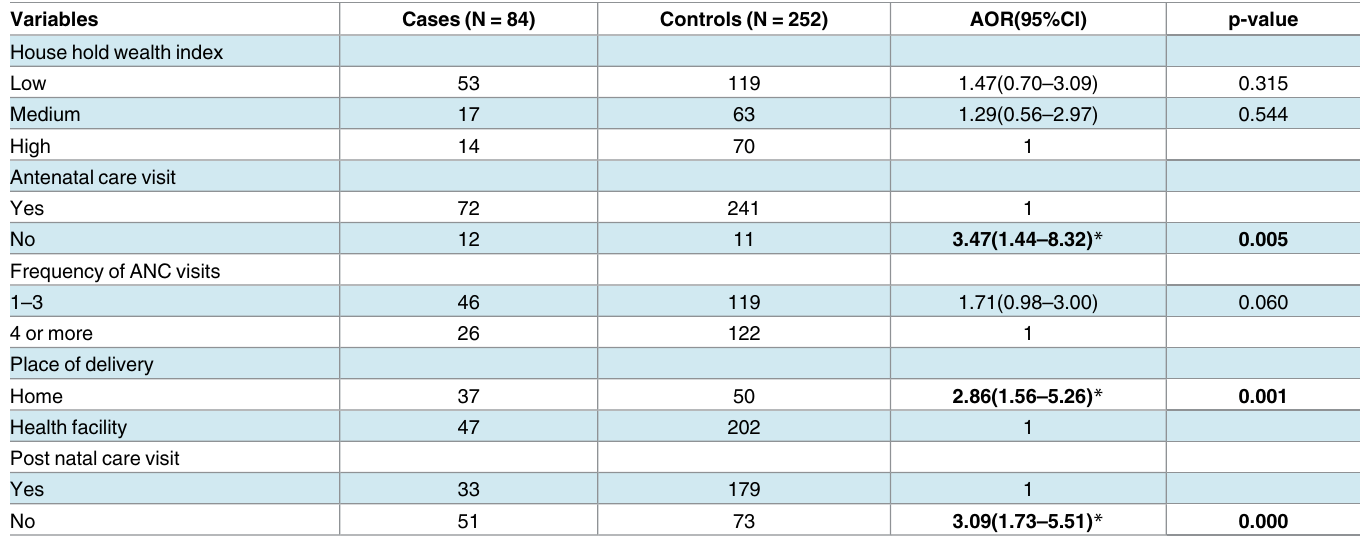
Table 3. Multivariate logistic regression analysis depicting the independent predictors of neonatal mortality in North Shoa Zone of Amhara Regional State, 2014.